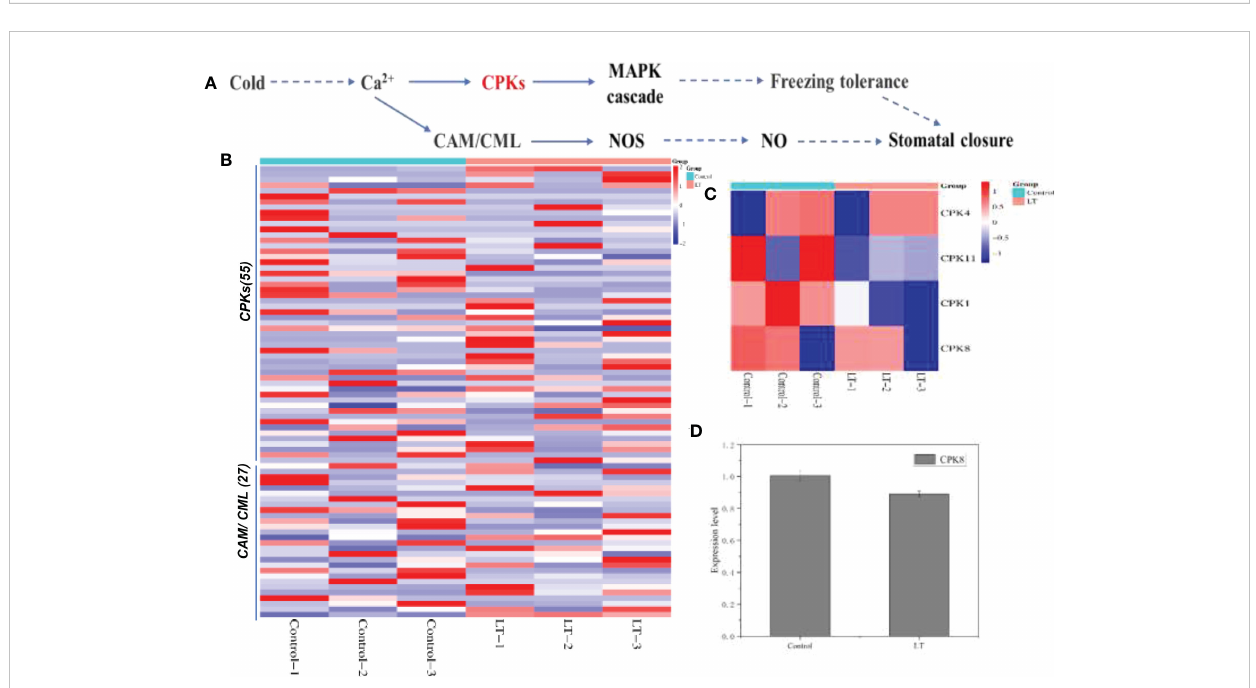
FIGURE 6 Response of stomatal closure induced by calcium ion signal to freezing stress. (A) The KEGG database was used to construct the plant-pathogen interaction. (B) Based on the level of expression level, the DEGs of calcium signal transduction under cold stress were hierarchically clustered. (C) On the basis of their expression level, the DEPs of CPKs were hierarchically clustered. (D) The expression of CPK8, a key protein induced stomatal closure, was down-regulated under cold